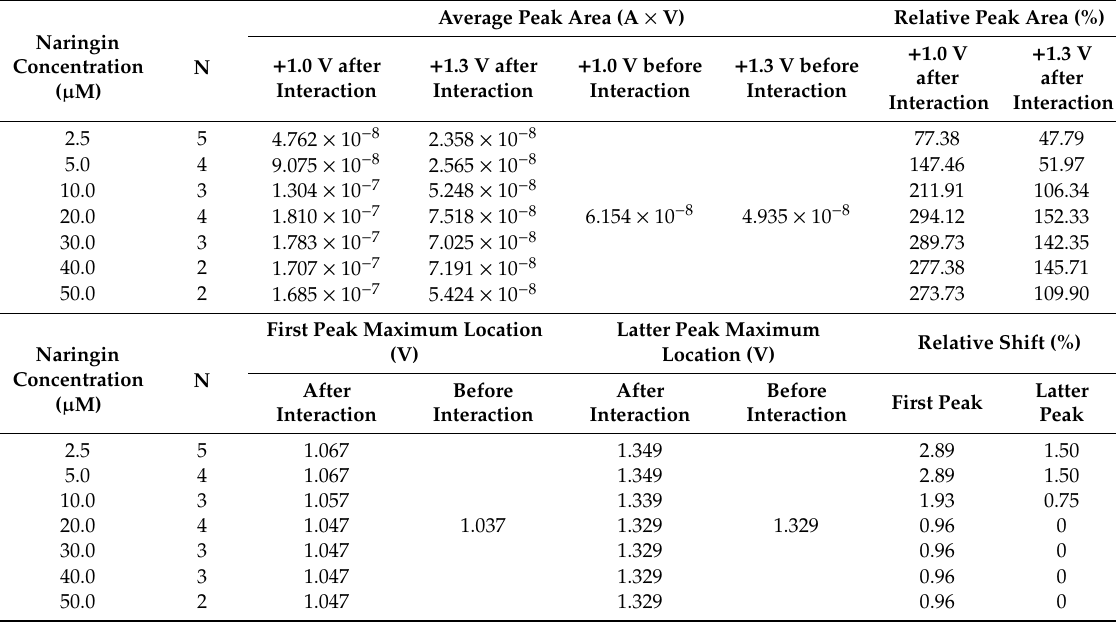
Table 2. Electrochemical parameters describing the naringin-oligonucleotide